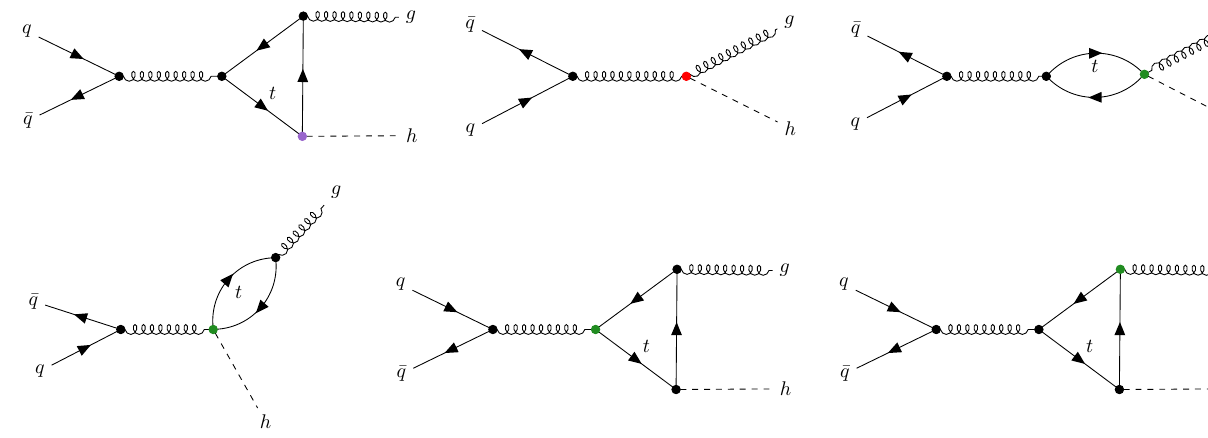
Fig. 4 Generic diagrams of the q ¯ q -channel diagrams in the SMEFT. The color coding is the same as in Figs. 1–3